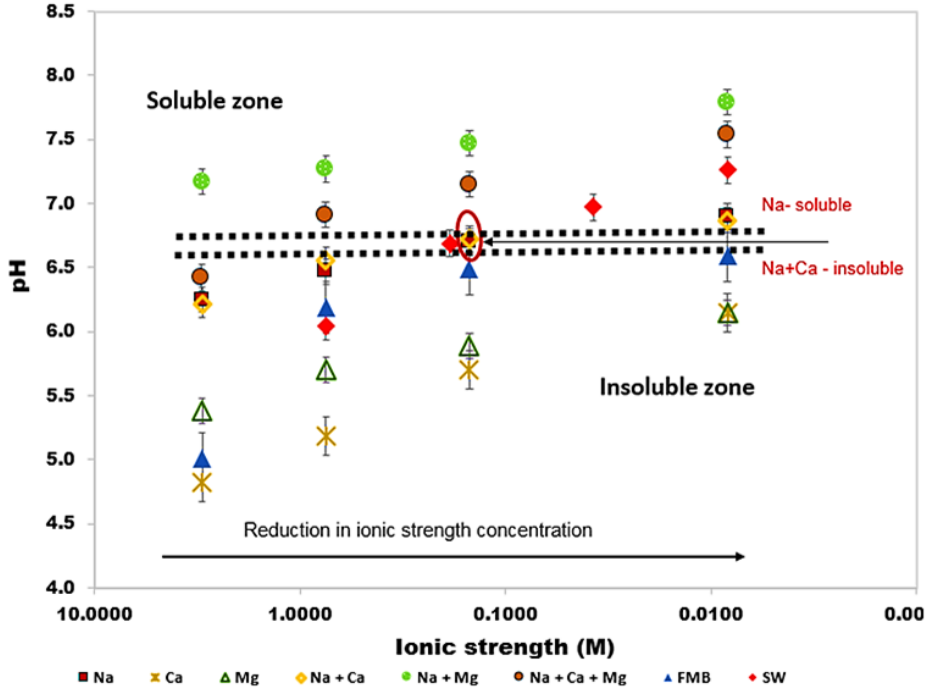
Figure 4. Plot of relationship between pH and ionic strength of different aqueous solutions of rhamnolipid. The ionic strength decreases from left to right and the dashed lines represent the threshold pH, above and below the two lines rhamnolipid was soluble and insoluble respectively while in-between both effects were observed. The red circle shows electrolytes with same pH but different soluble